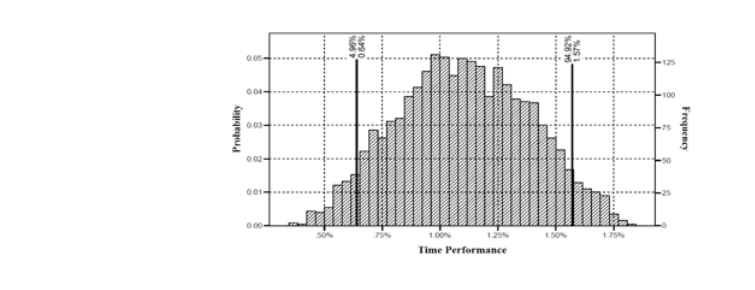
Figure 2 Probability density distribution for time performance, 2,563 simulated cases